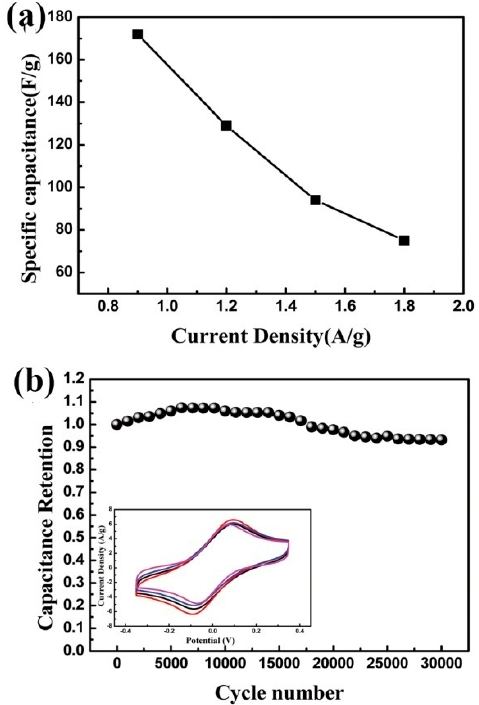
Figure 7. ( a ) Specific capacitance of the super capacitor at a series of current densities. ( b ) CV curves of the super capacitor at 10,000, 20,000 and 30,000 cycles, respectively [75]. Copyright 2016, the Royal Society of Chemistry